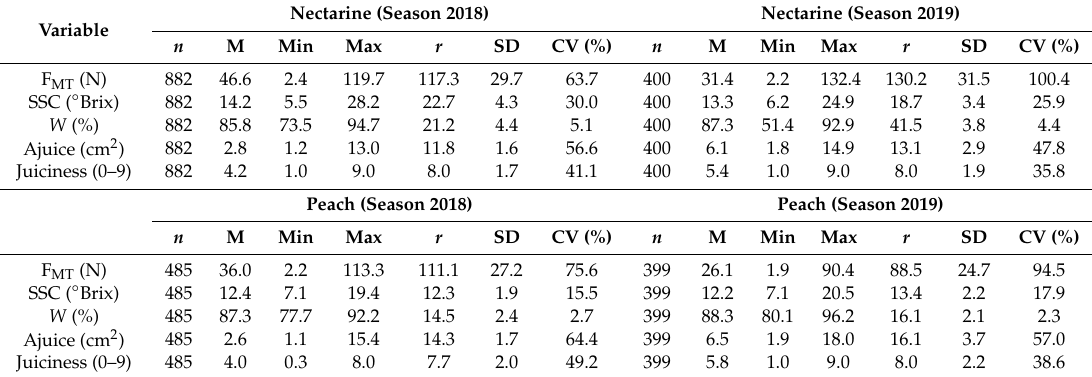
Table 2. Basic statistics by product and season. M (mean), R (range), SD (standard deviation), CV (coe ffi cient of variation), F MT (maximum force Magness–Taylor), SSC (soluble solid content), W (water content), Ajuice (instrumental juiciness), Juiciness (sensory juiciness), Min (minimum), and Max